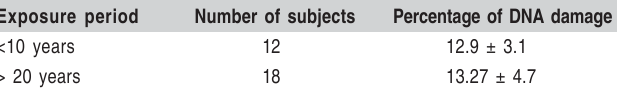
Table 2 - Percentage of DNA damage according to duration of exposure in experimental